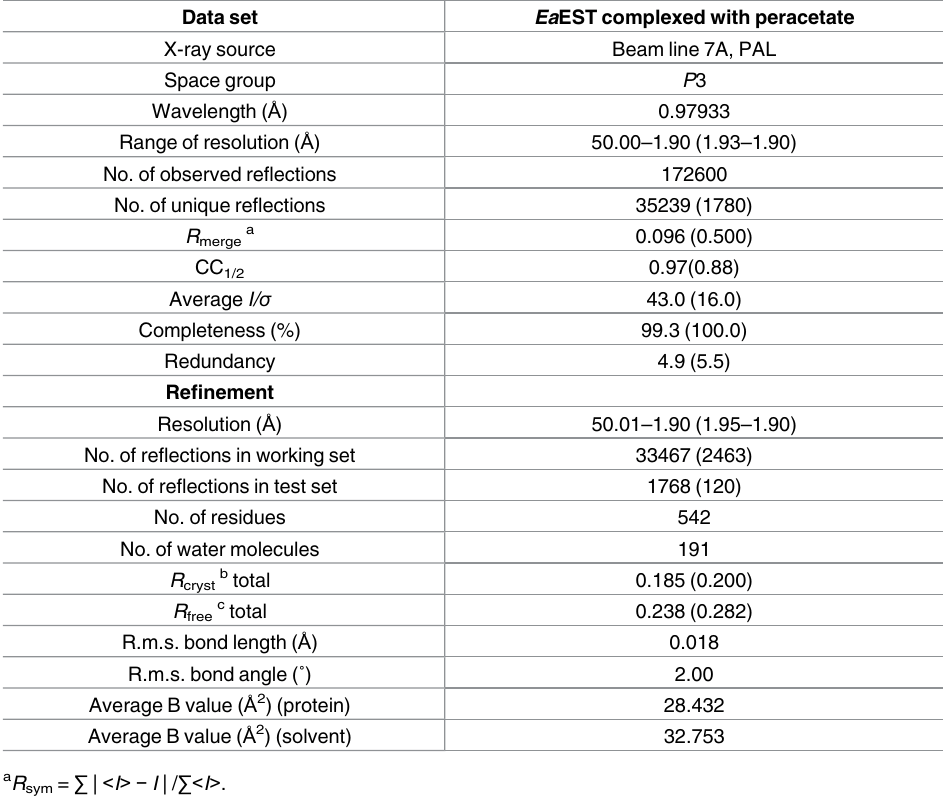
Table 1. X-ray diffraction data collection and refinement